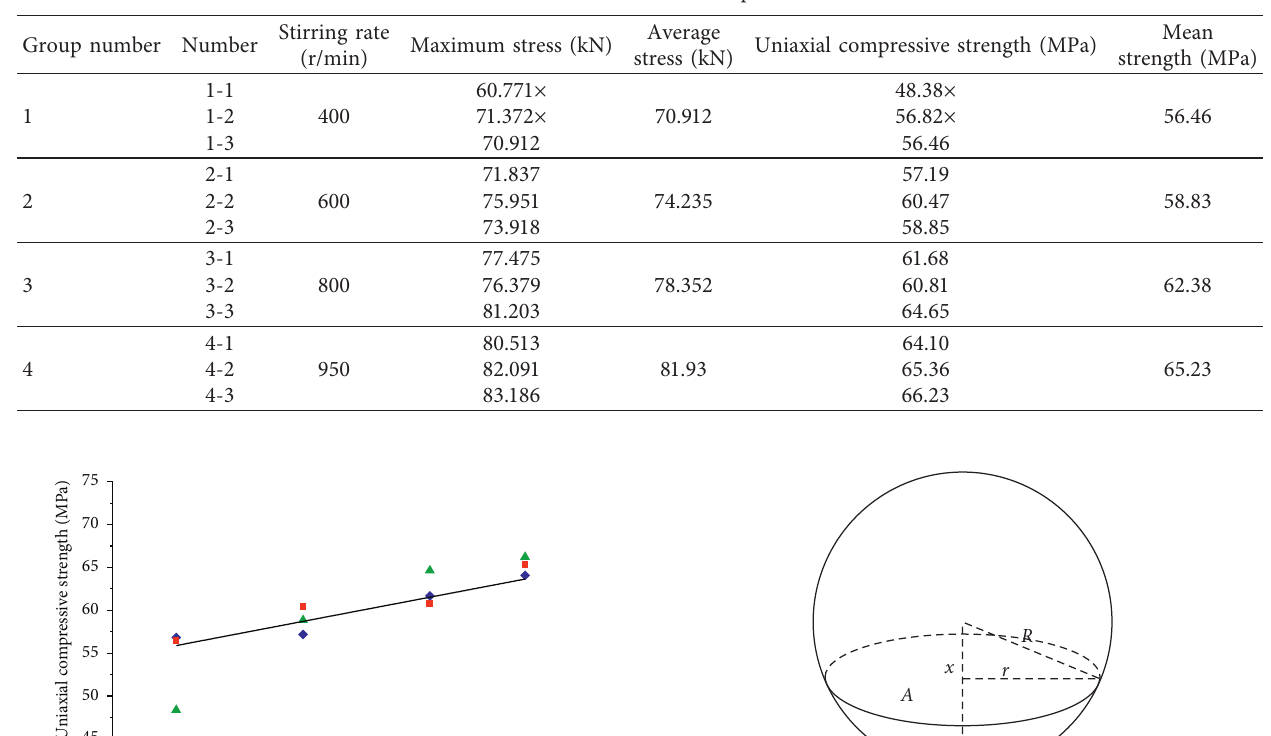
Table 2: Data of the uniaxial compressive test.